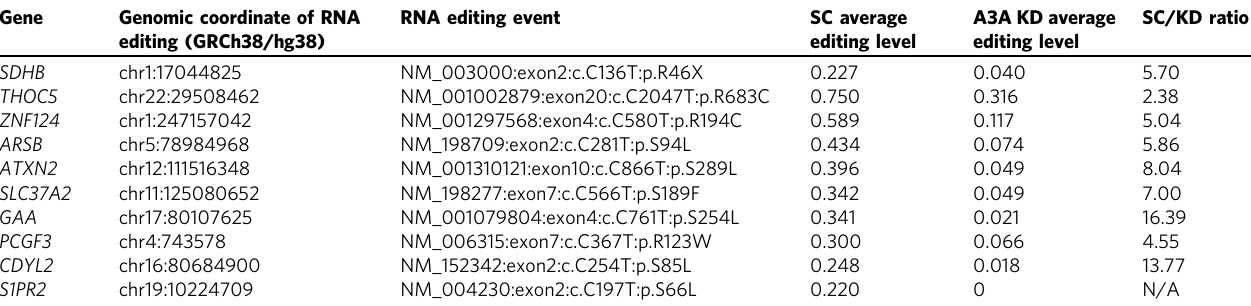
Table 1 Gene transcripts that acquire high levels of non-synonymous C>U RNA editing in M1 macrophages. Gene Genomic coordinate of RNA editing (GRCh38/hg38)